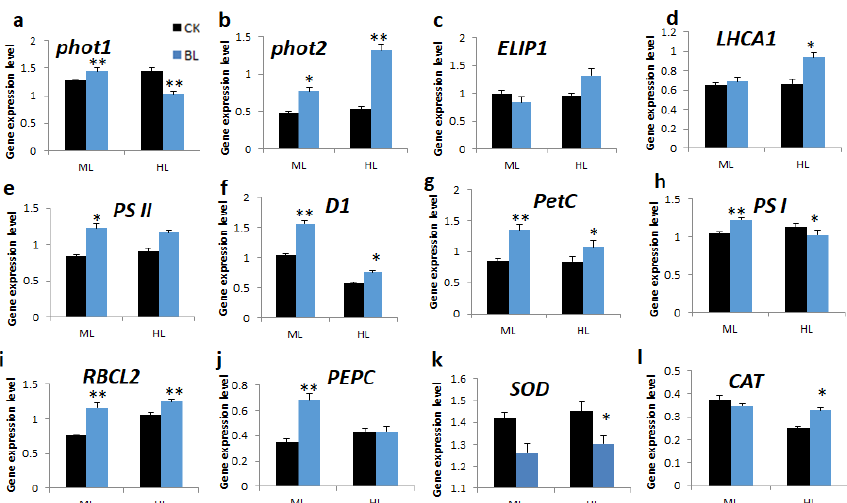
Figure 8. Quantitative RT-PCR showed that BL-acclimation altered gene expression patterns of vanilla orchids. RNA samples were collected after exposure to moderate light at 500 μmol m 2 s -1 (ML) or high light at 1000 μmol m − 2 s − 1 (HL) for two weeks. Error bars indicate the SD of the mean from three bioreplicates. Statistical significance was determined by a one-way analysis of variance (ANOVA), followed by Dunnett’s test. * p < 0.05, ** p < 0.01.